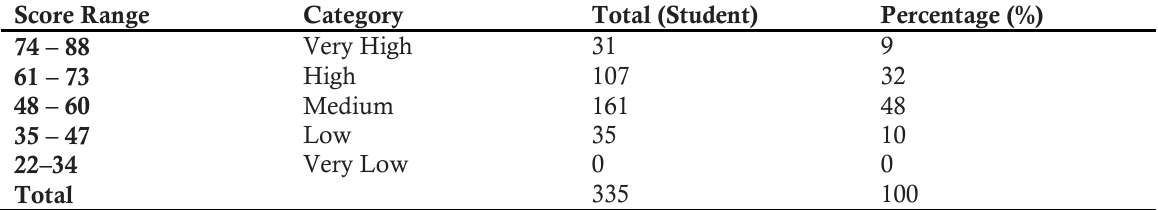
Table 4. Classification of Student Interpersonal Conflic Management Scores